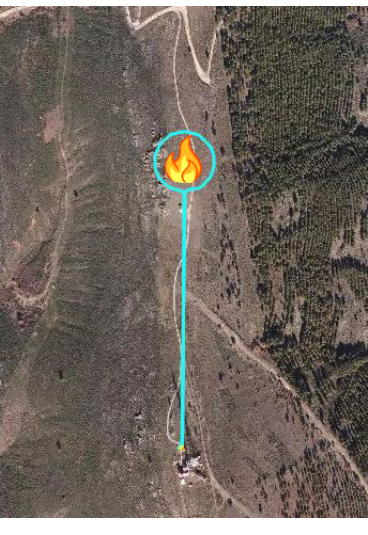
Figure 13. Real trajectory.